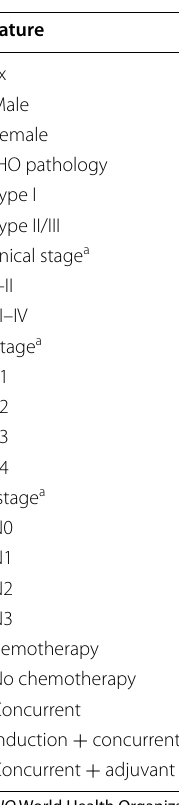
Table 2 Dose-volume histogram data for planning target volumes in the 749 patients with NPC